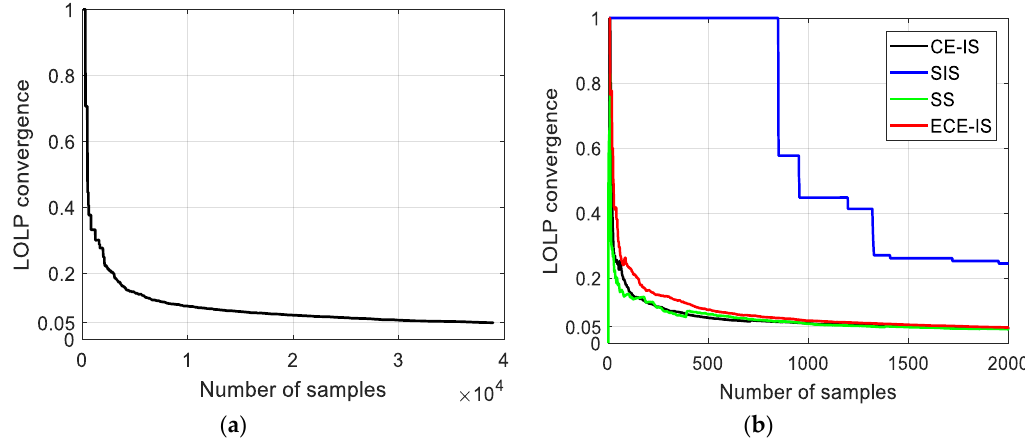
Figure 10. ( a ) System LOLP in case of using standard MCS method; ( b ) system LOLP in case of using CE-IS, SIS, SS, and ECE-IS approaches.